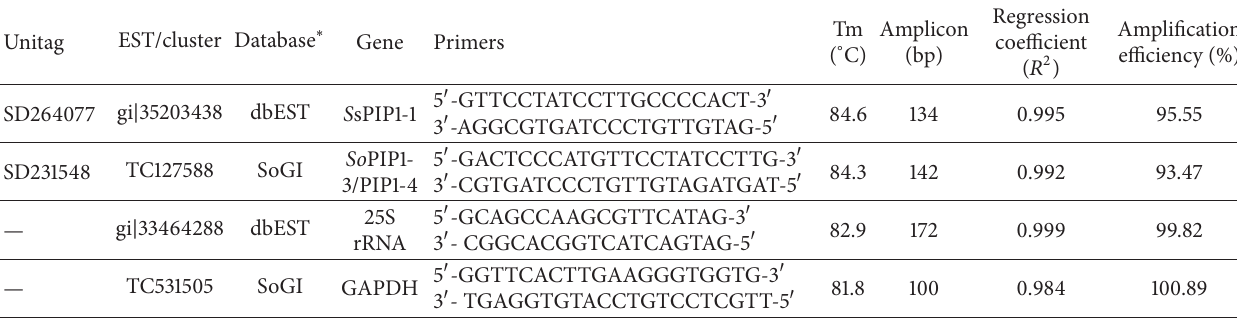
Table 5: Primers sequences for RT-qPCR of S sPIP1-1, So PIP1-3/PIP1-4 (designed from sugarcane ESTs), 25S rRNA, and GAPDH (as reference genes).